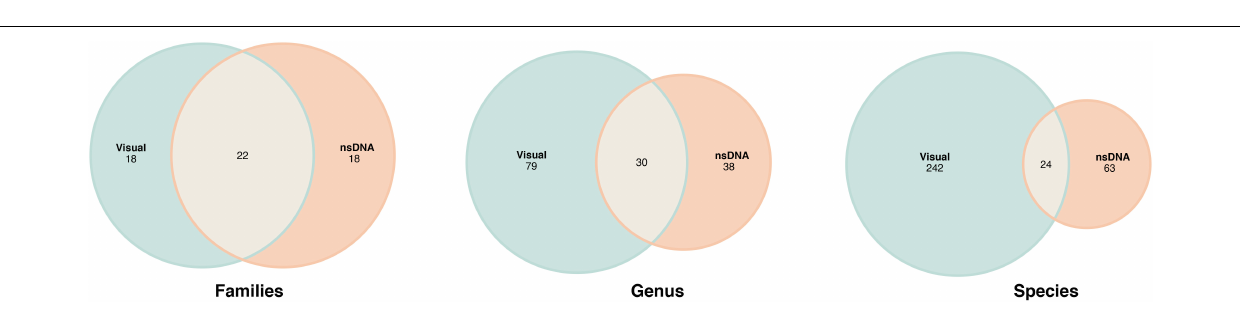
within a small spatial scale subject to tidal and water